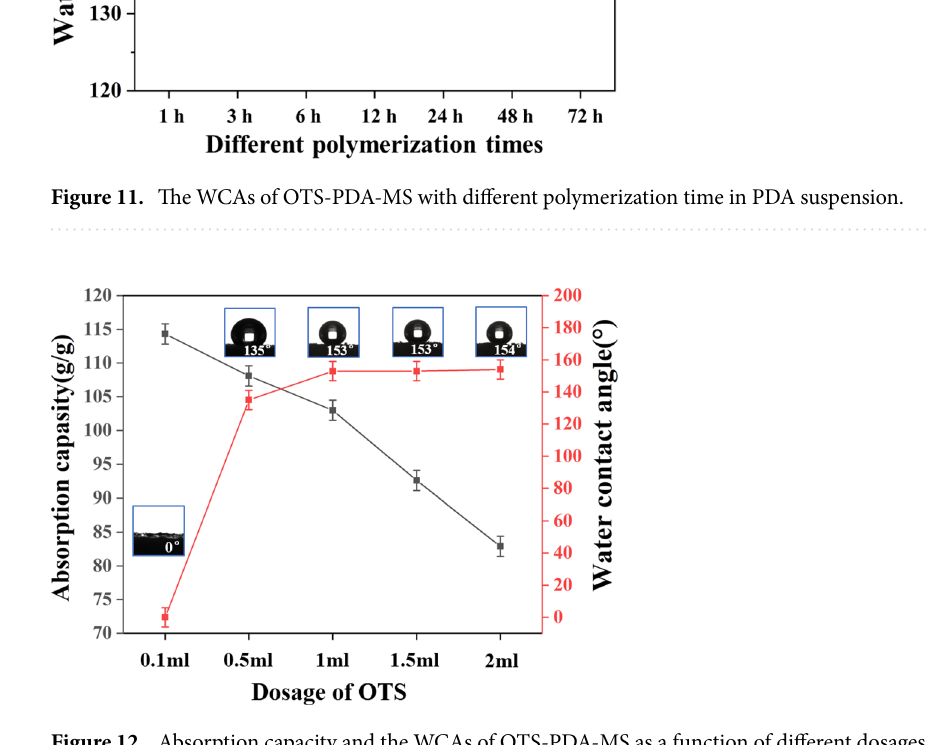
Figure 12. Absorption capacity and the WCAs of OTS-PDA-MS as a function of different dosages of